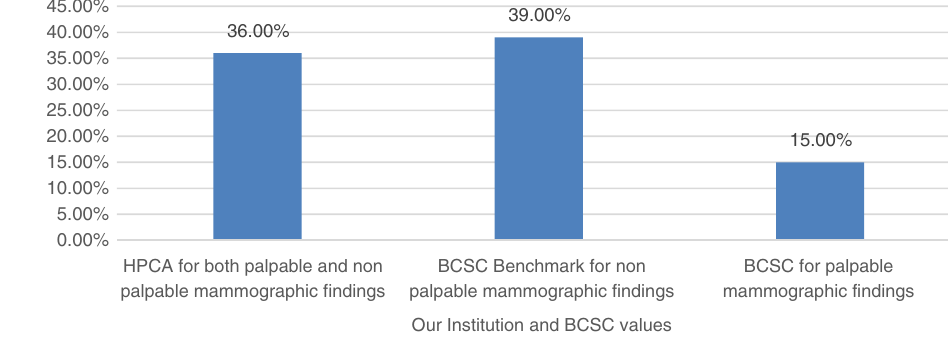
Fig. 5 Percentages of minimum invasive cancers (<1.0 cm) or